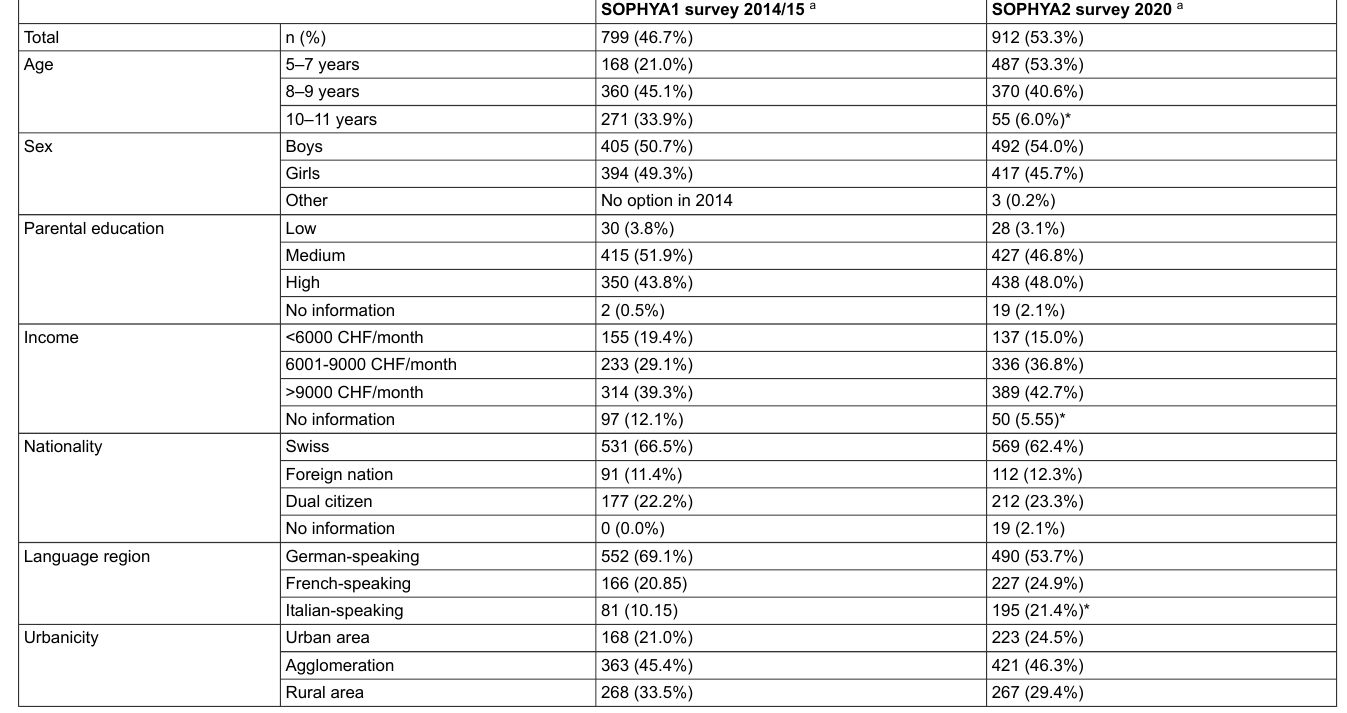
SOPHYA1 survey 2014/15